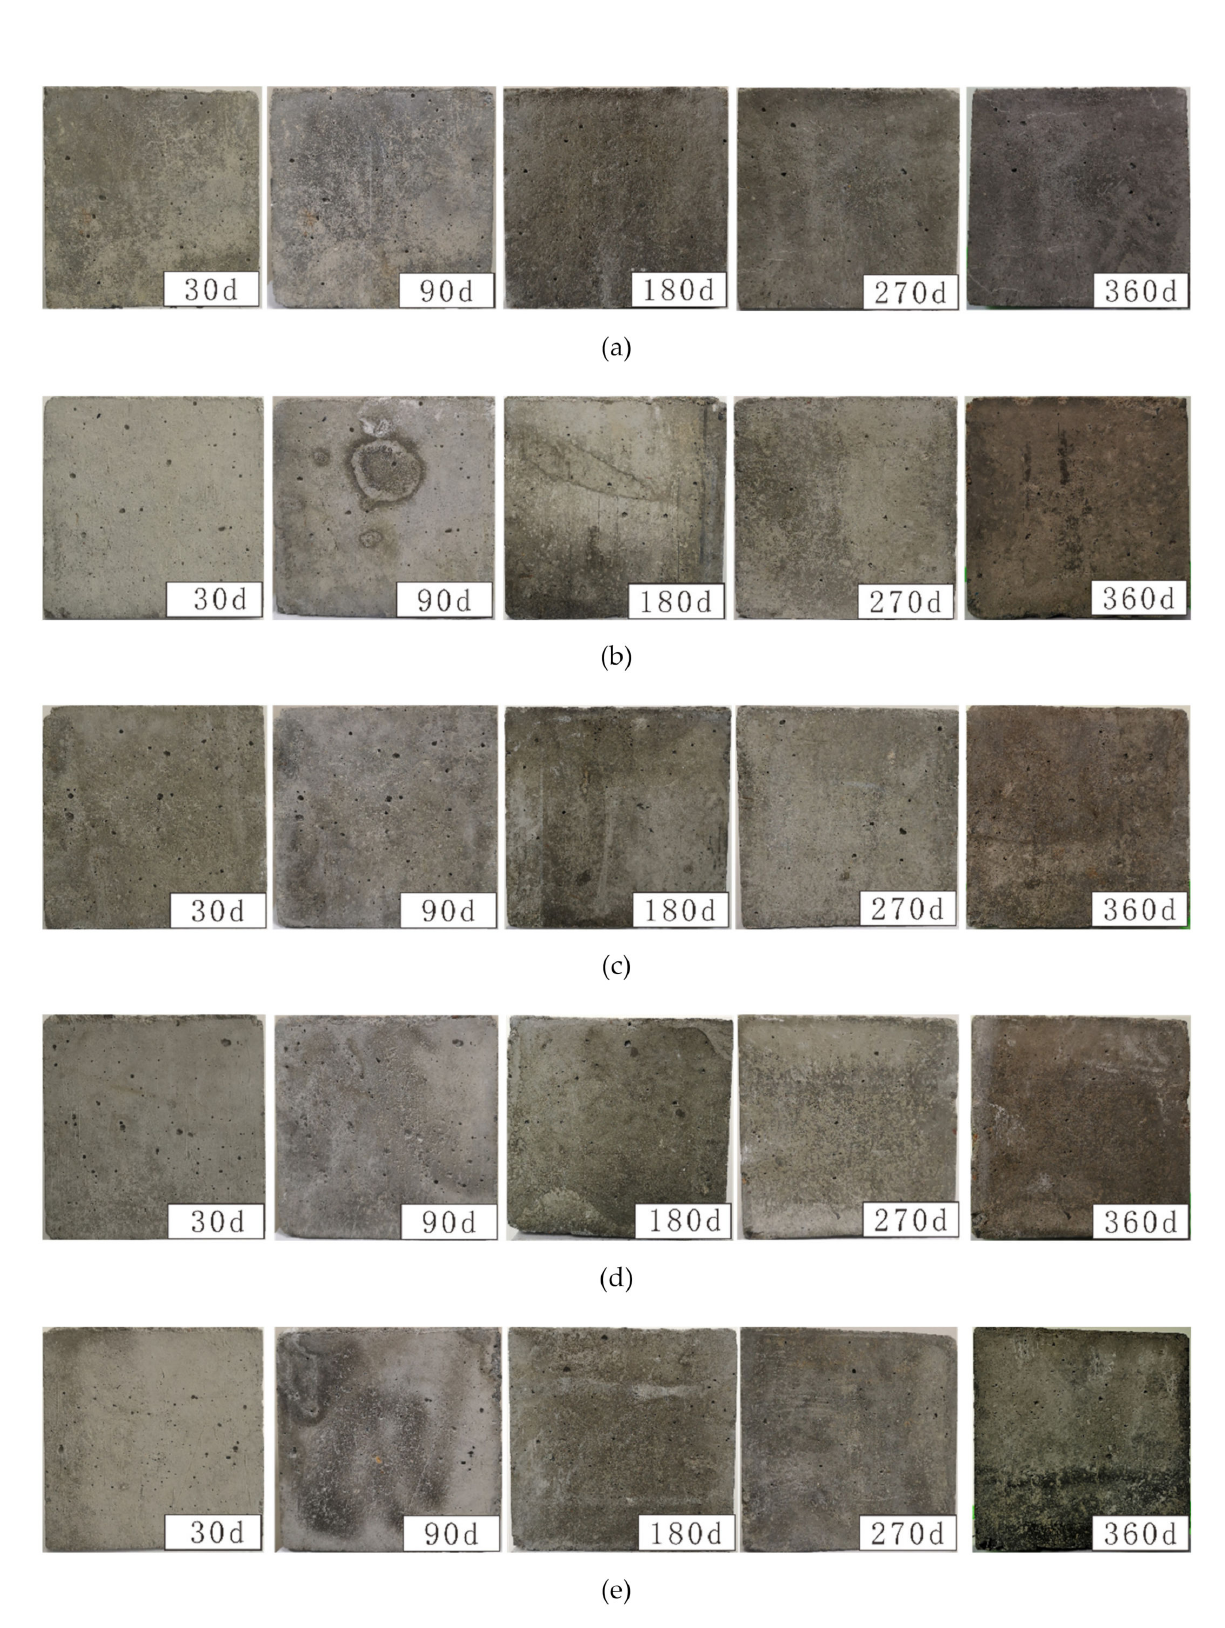
Figure 2. Changes of specimen appearance immersed in CSO, CS0.5, CS1, CS2, and CS3 ( a – e ,